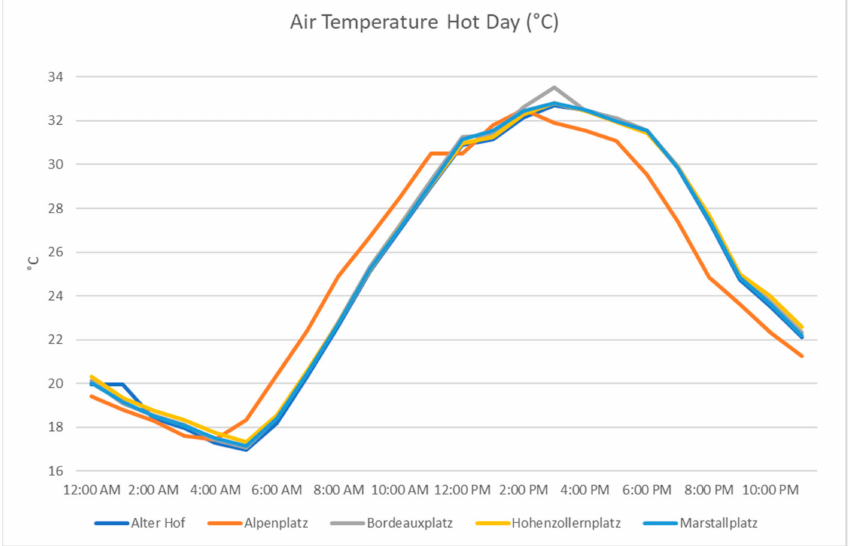
Figure 11. Simulated air temperature on the hot